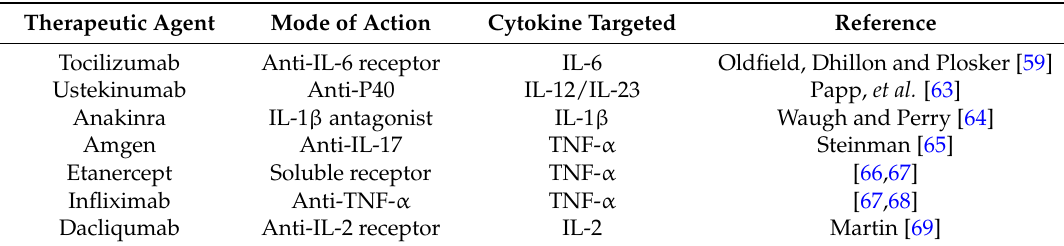
Table 1. Drugs used to block cytokine activity 1